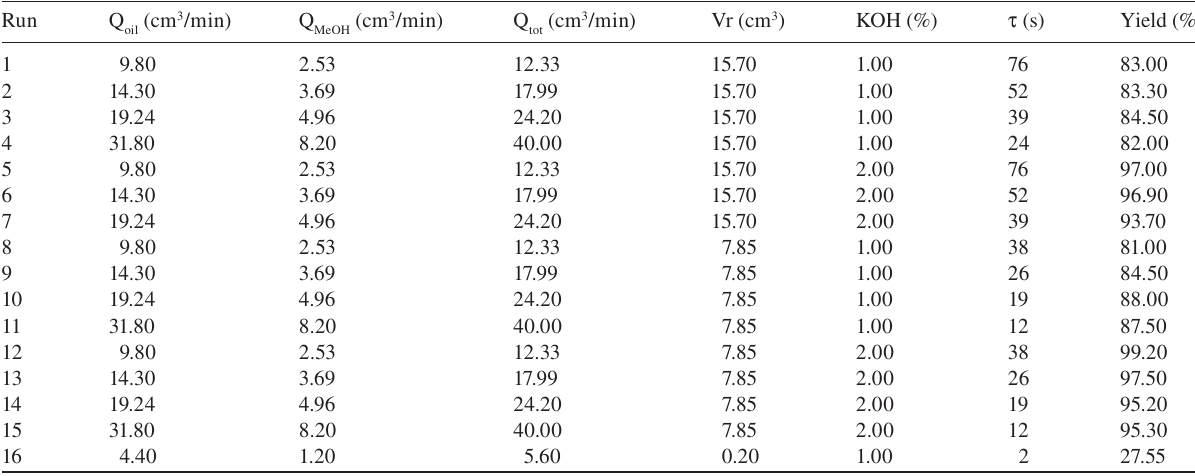
Table 1 List of the performed experimental